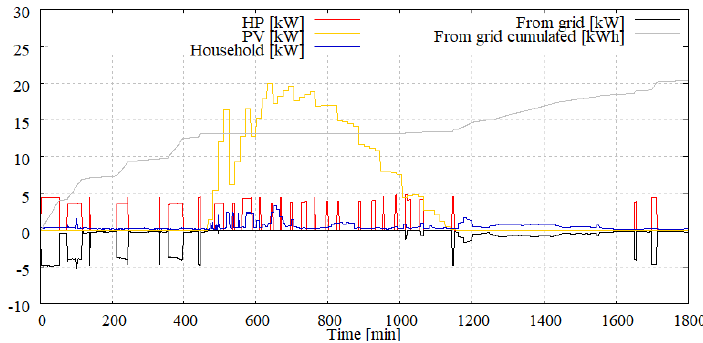
Figure 6. Single building daily electrical demand with